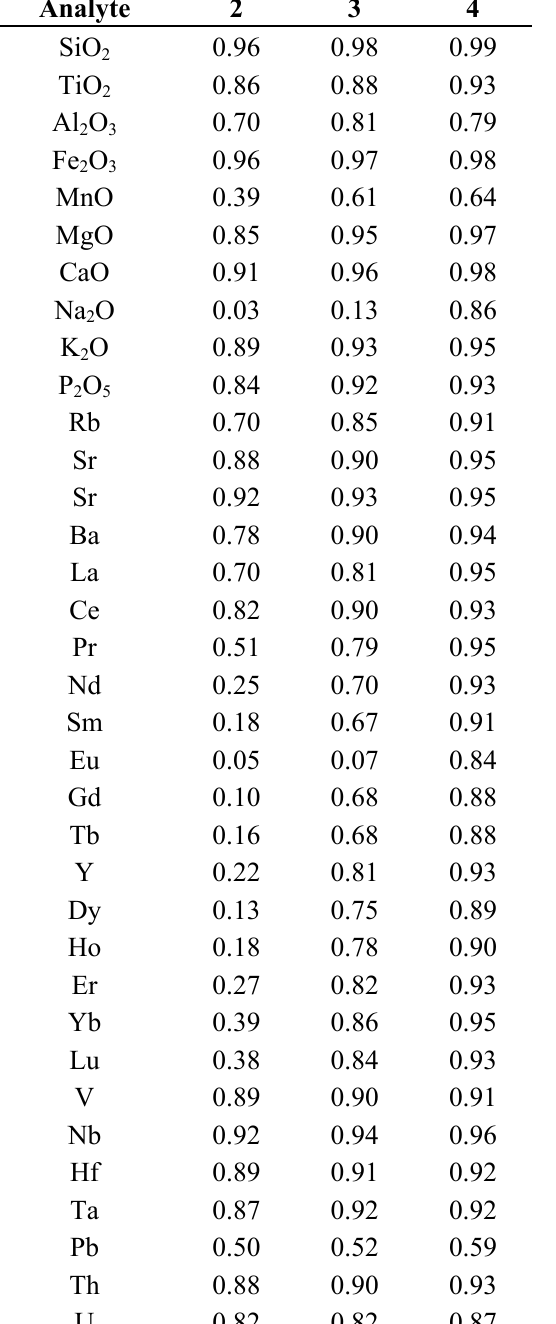
Table 1. Coefficients of determination (CD) for each analyte in a two, three and four end member PVA solution for all Papagayo samples. See text for explanation of CDs. Notice the low CDs for Na and Eu in a three end member